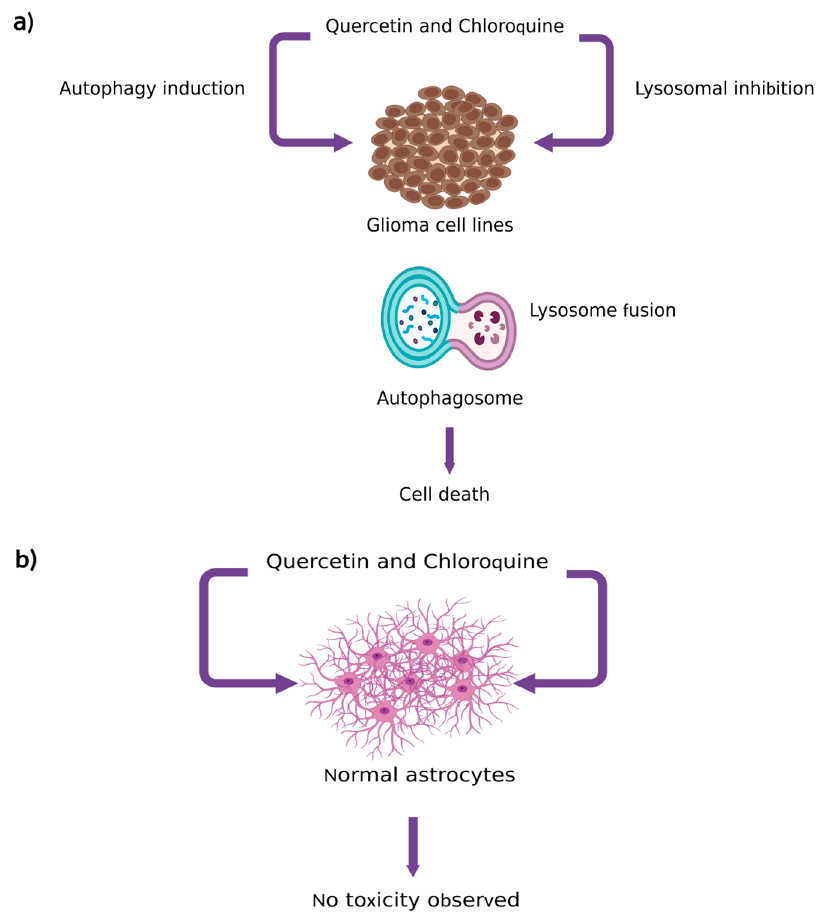
Figure 6. Co-administration of Que with chloroquine in ( a ) glioma cell lines and ( b ) normal astrocytes cells; ( a ) Que synergistically enhanced chloroquine-mediated lysosomal inhibition and triggered autophagy leading to excessive increase of autolysosomes and lysosomes causing cell death; ( b ) no toxicity effect resulted after co-administration of Que with chloroquine in normal astrocyte [100] (created with biorender.com; 25 February